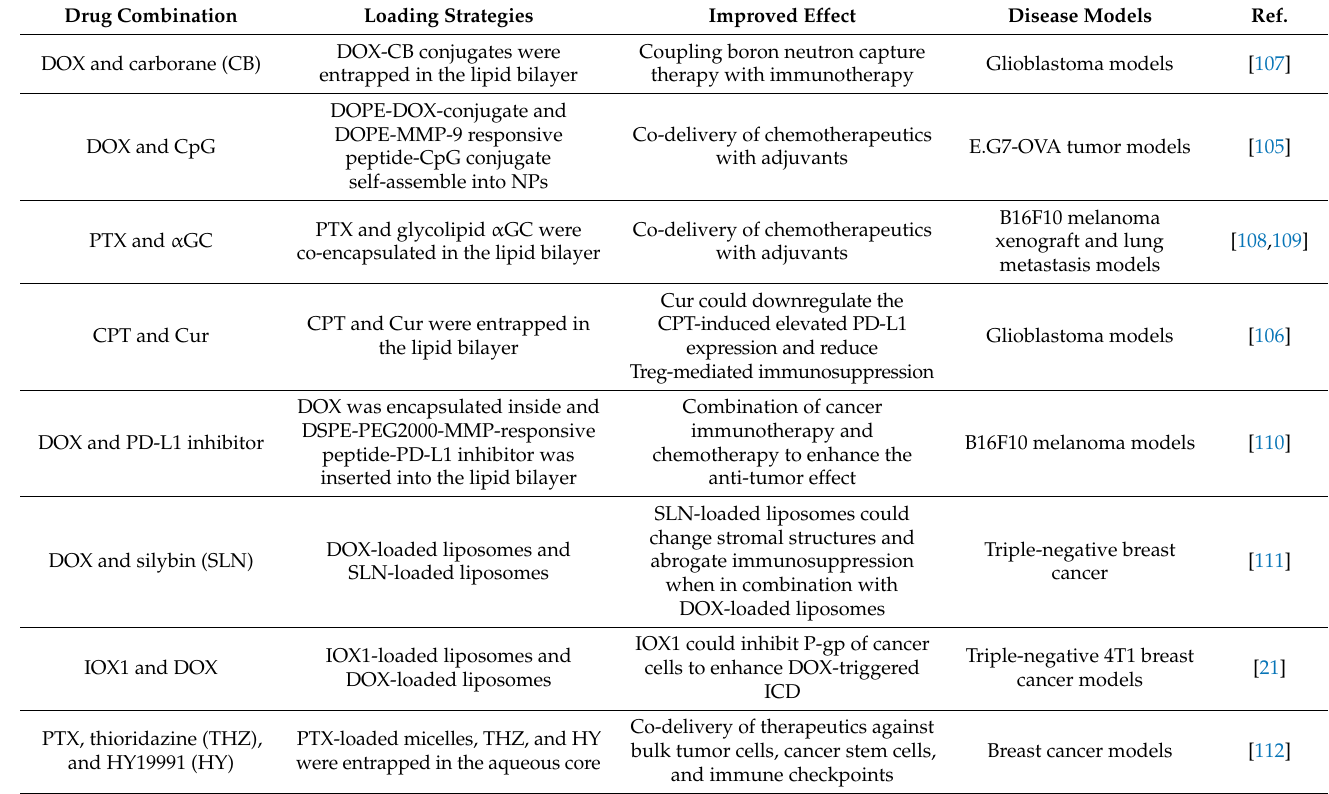
Table 1. Liposome-based combination preparations for cancer